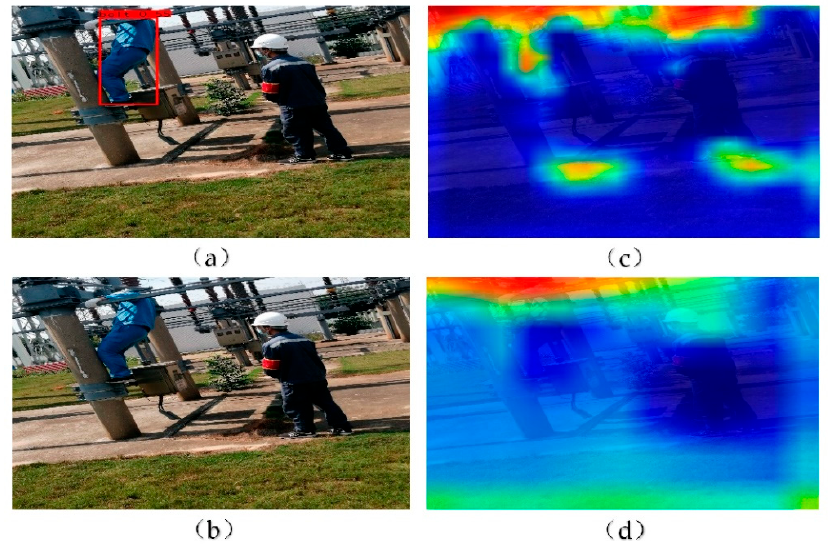
Figure 6. Results of original network misdetection samples: ( a ) prediction of YOLOv4-tiny; ( b ) prediction of YOLO-DFAN; ( c ) heatmap of YOLOv4-tiny; ( d ) heatmap of YOLO-DFAN.